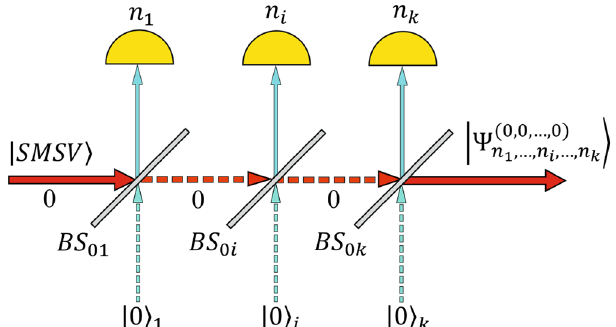
Figure 1. Optical scheme used to shape even/odd SCS of large amplitude with fidelity over 0.99 . It consists 1, 2, . . . , k ) following one after another of a sequence of k beam splitters with transmittance coefficient t i ( i = through which the original SMSV state with squeezing amplitude s passes forming the entangled hybrid state in Eq. (24). Part of the reflected photons ( n 1 , n 2 , . . . ., n k ) is simultaneously measured in auxiliary modes resulting 2 m n 2 n k in either even CV (Eq. (25)) in the case of n 1 N or odd CV (Eq. (26)) heralded states + + · · · + = 2 m 1 . The conditional CV states can approximate either an even or an n 2 n k provided that n 1 N + + + · · · + = 1, 2, . . . , k ) odd SCSs under certain values of one parameter y k defined by s and t i ( i =